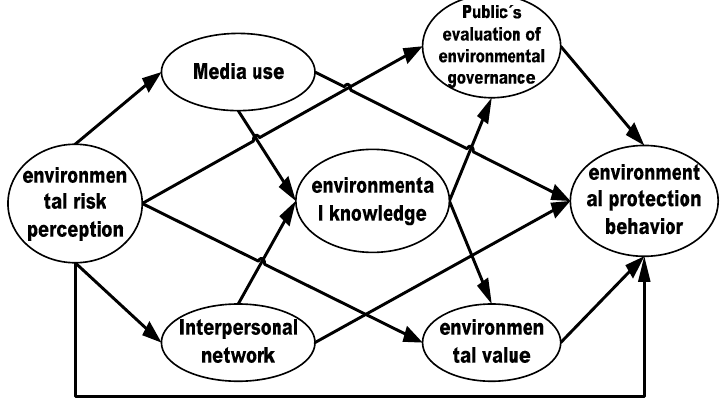
Figure 5. Risk attenuation path: from environmental risk perception to environmental protection behavior.